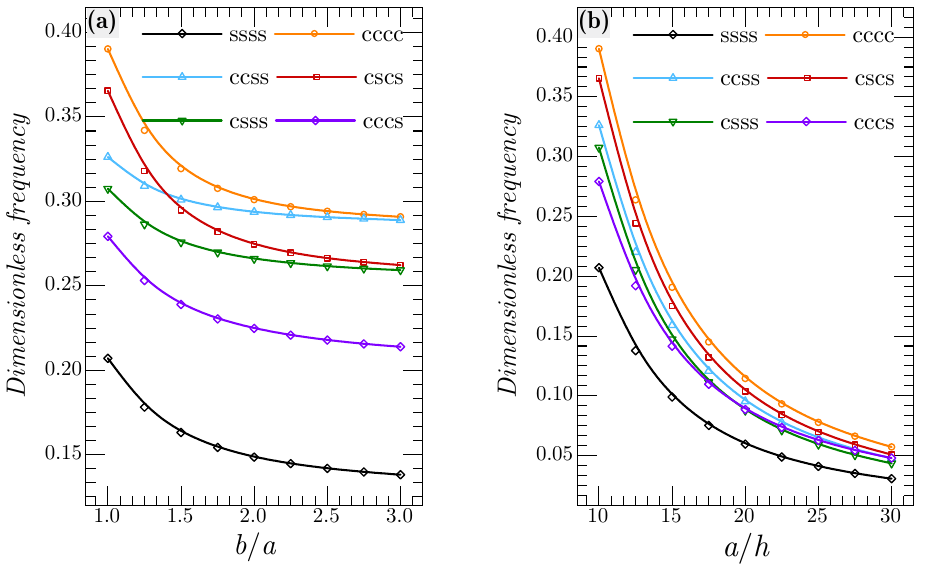
Figure 7. The effect of the geometry parameters b / a and a / h on the dimensionless frequency of a spherical shell for various boundary conditions ( 𝑁 = 9 , 𝑉 (cid:3030)(cid:3041)(cid:3047) = 0.01 , 𝑉 (cid:3040)(cid:3028)(cid:3051)(cid:3033) = 0.1 , 𝑉 (cid:3040)(cid:3036)(cid:3041)(cid:3033) = 0.3 ). ( a ) inplane ratio b / a , ( b ) slenderness ratio a / h.